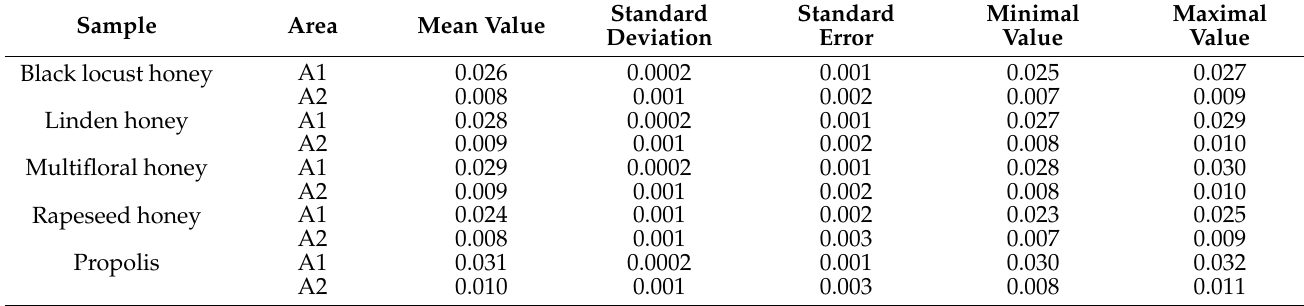
Table 8. Bioconcentration factor for